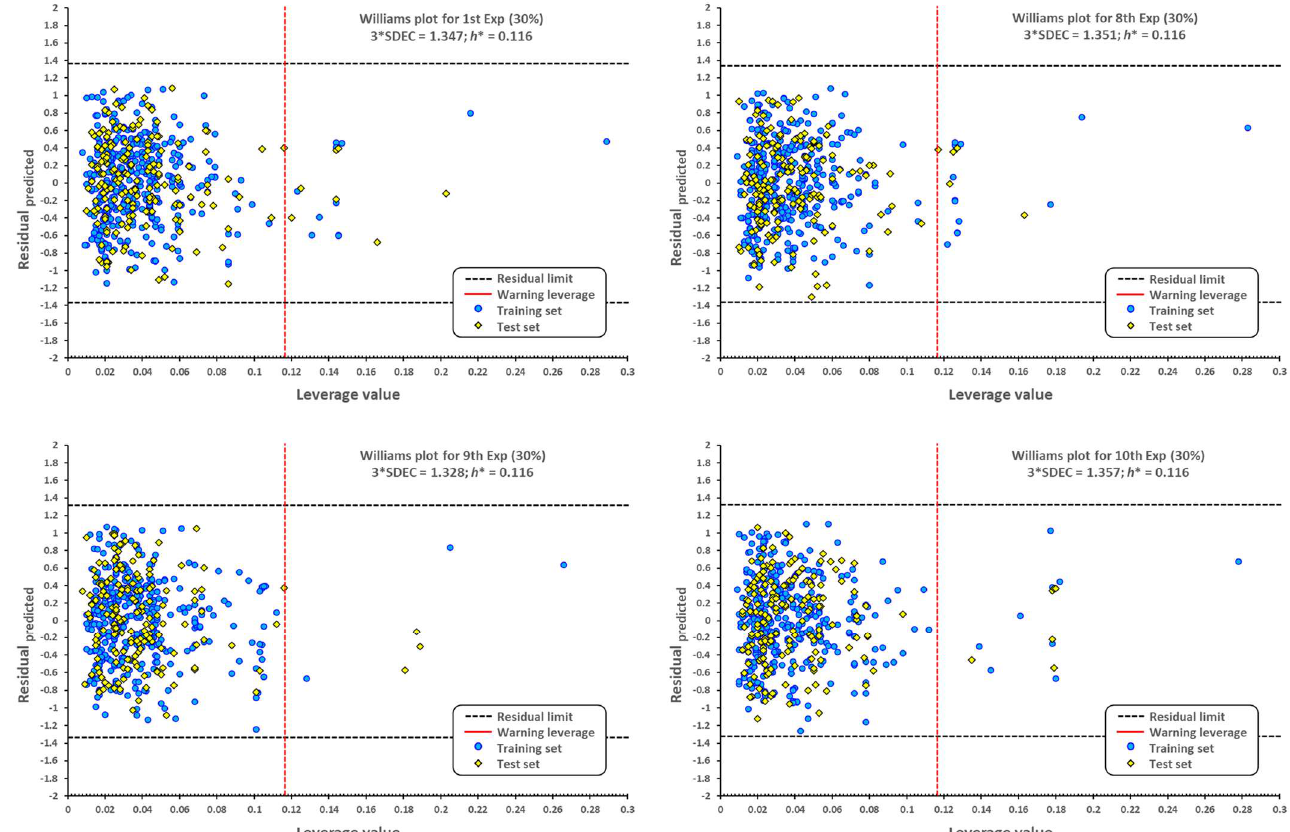
Figure 2. Williams plots for molecules with antibacterial activity against A. baumannii . The dotted vertical line in red indicates the warning leverage limit ( ℎ ∗ = 3𝑝/𝑛 , where n is the number of molecules and p is the number of descriptors in the model plus one). The upper/lower dotted horizontal lines in black represent the boundaries for which the triple of the standard deviation (3 × SDEC) value is used.